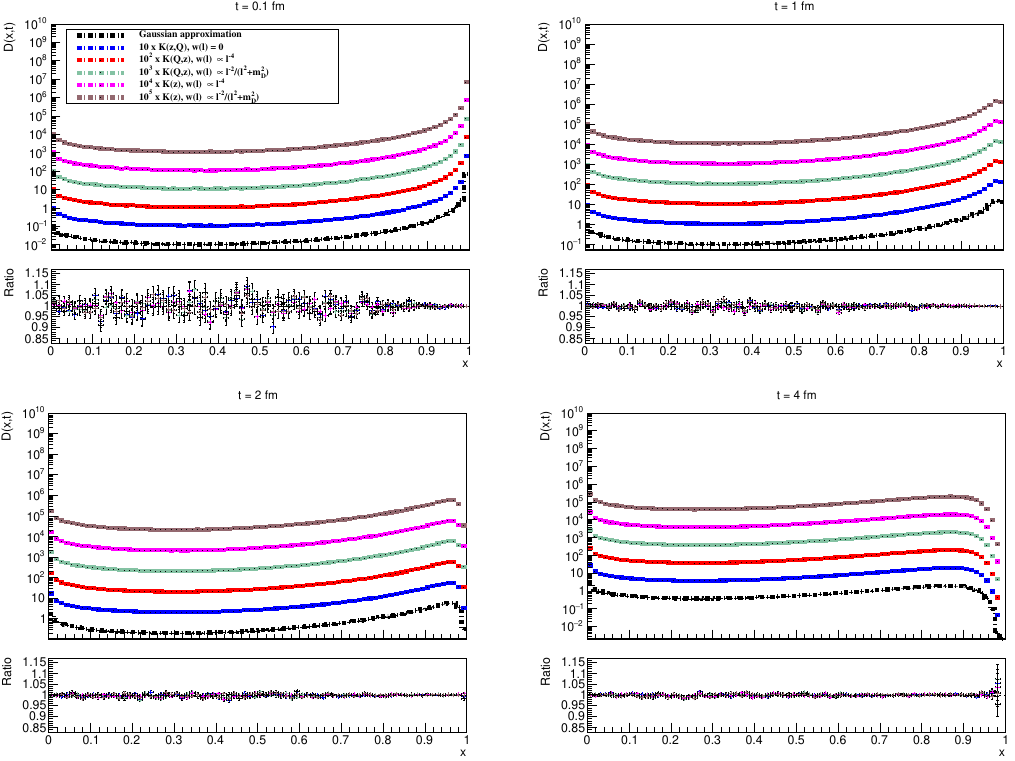
Figure 4 . The integrated x distributions (multiplied by the factors 10 n , n = 0 , . . . , 5 ) for the evolution time values t = 0 . 1 , 1 , 2 , 4 fm, for different kernels: the Gaussian approximation, K ( z ) and K ( Q , z ) , and different collision terms: no collision term, the collision term as in eq. (2.6) and as in eq. (2.7). The reference distribution used for the ratio plots is the one for the full kernel K ( Q , z ) and the collision term of eq.